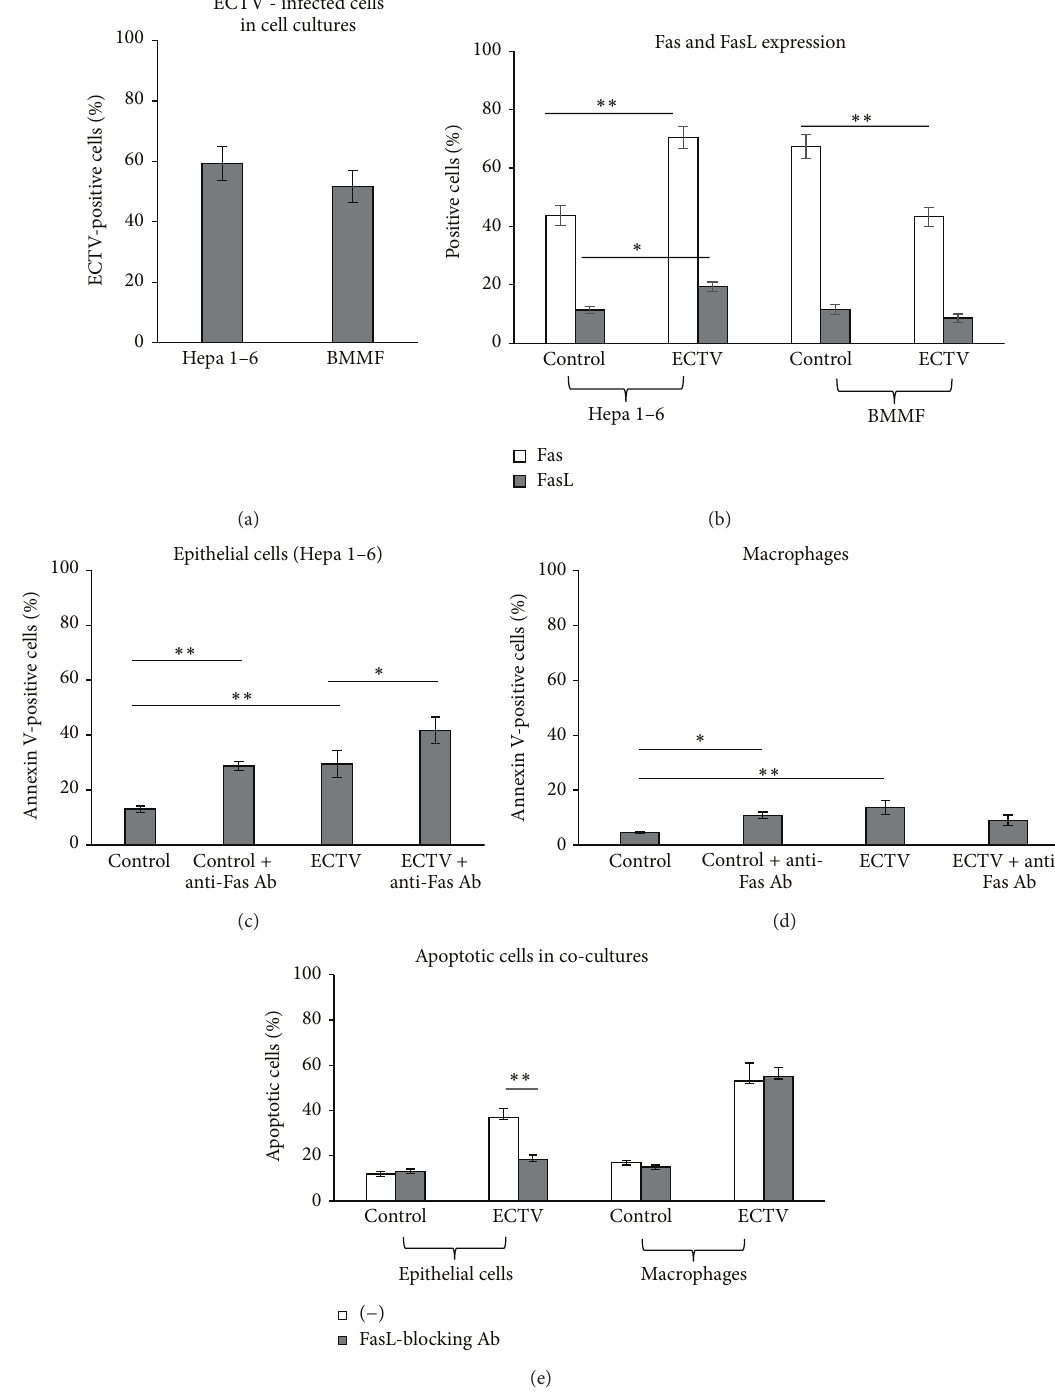
Figure 5: ECTV-infected macrophages and epithelial cells show different response to Fas-induced apoptosis. (a) Percentages of ECTV- infected cells in Hepa 1–6 epithelial cell cultures and bone marrow derived macrophages (BMMF) at 24h p.i. (b) Percentage of Fas- and FasL-positive cells in epithelial Hepa 1–6 and BMMF cultures at 24h of ECTV infection. Percentage of apoptotic (annexin V-positive) cells in epithelial Hepa 1–6 (c) and BMMF cultures (d), infected or not with ECTV and exposed or not to anti-Fas cytotoxic antibody (10mg/mL). (e) Percentage of apoptotic cells in the cocultures of epithelial Hepa 1–6 and macrophage cells infected or not with ECTV and exposed to anti-FasL-blocking antibody (10 𝜇 g/mL). The bars represent the mean from 3 separate experiments ( 𝑁 = 3 ) ± SEM. ∗ Significant differences with 𝑃 ≤ 0.05 and ∗∗ 𝑃 ≤ 0.01